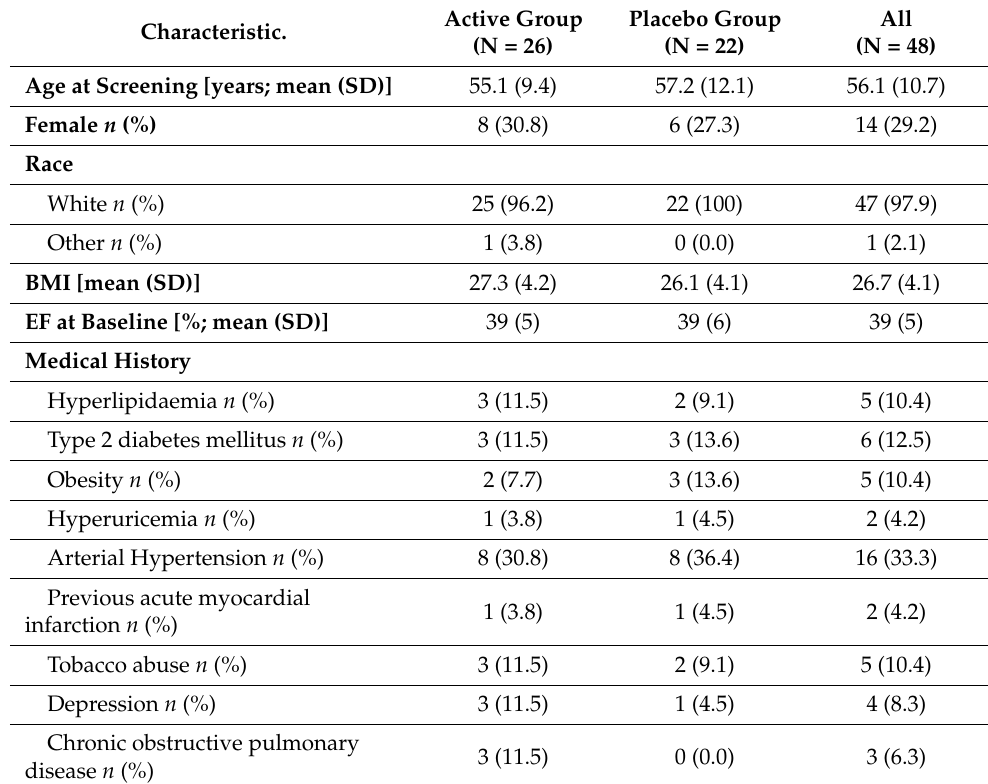
Table 1. Summary of Baseline Characteristics (ITT Population).